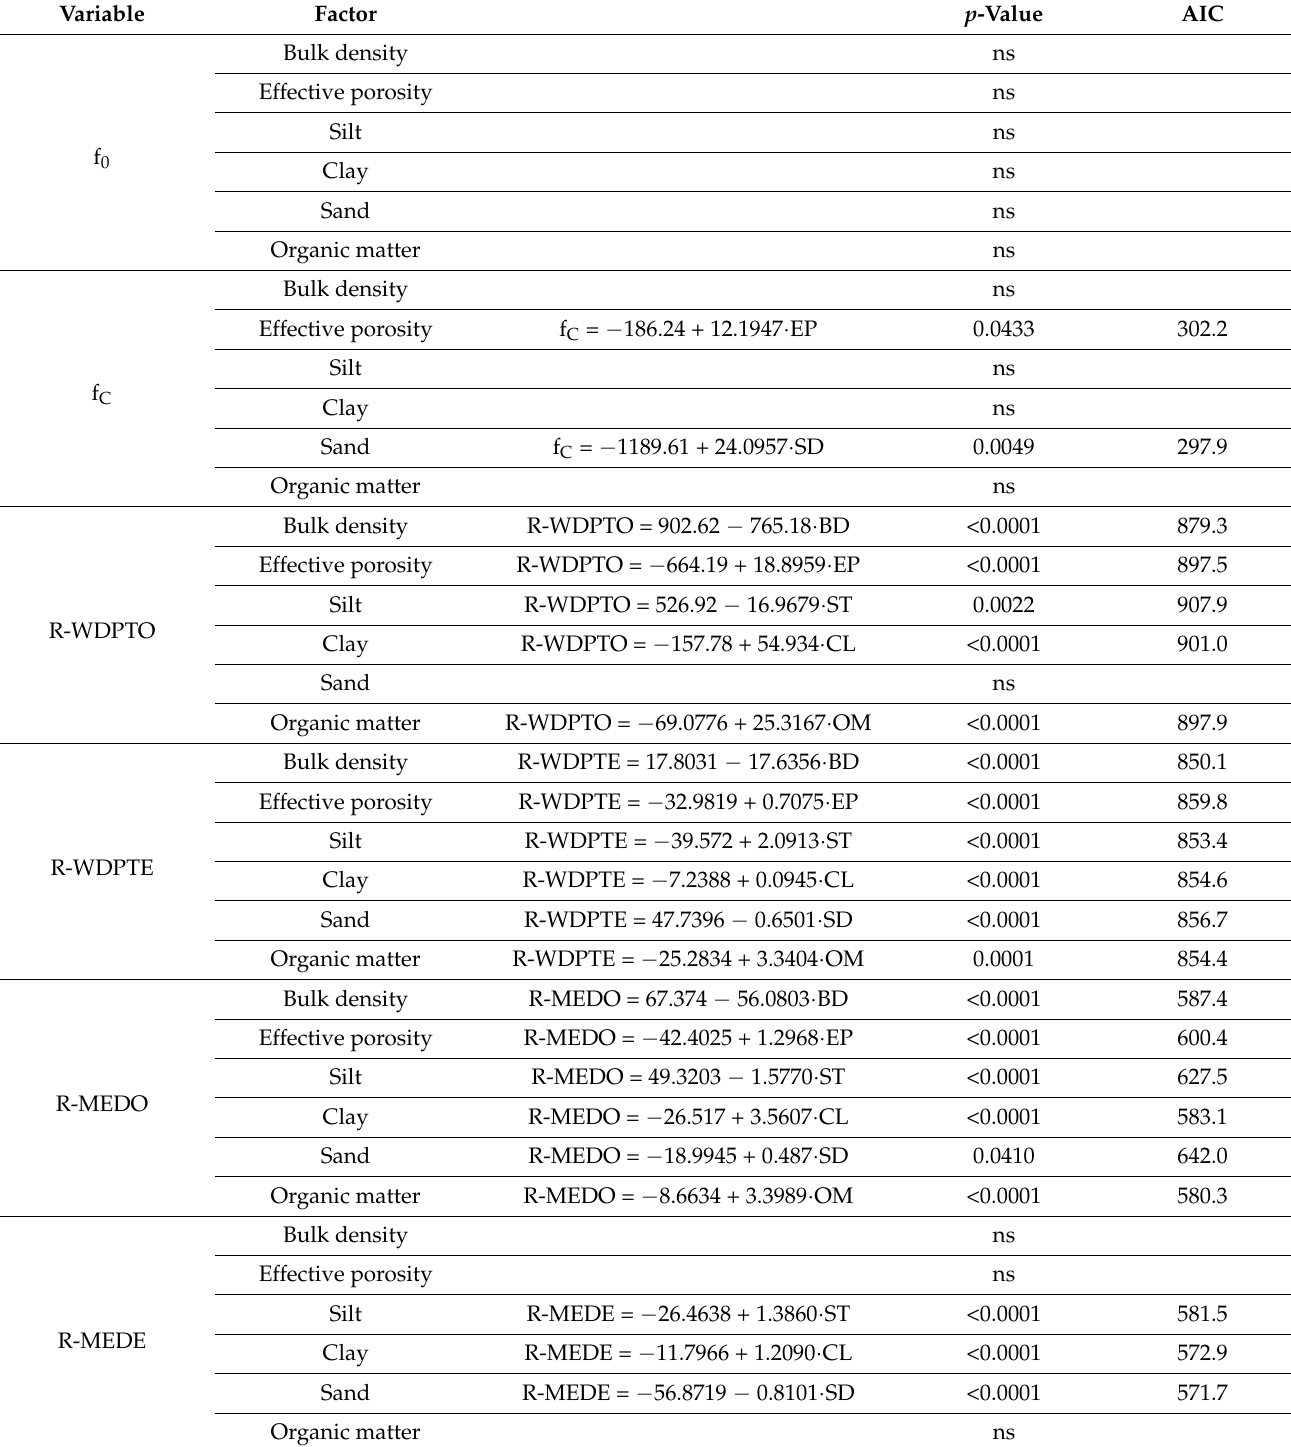
Table 3. Factors influencing soil infiltration and soil